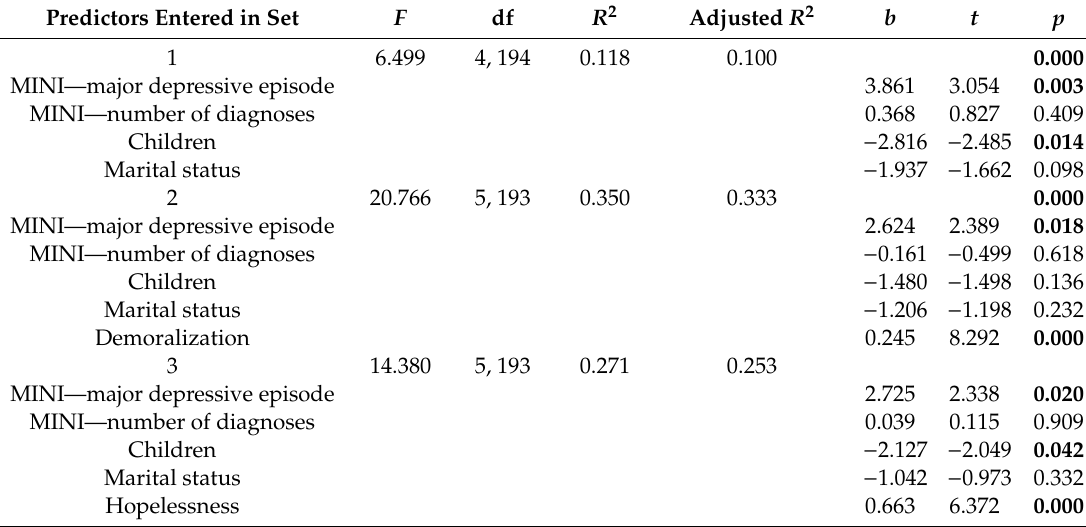
Table 3. Multiple linear regression equation, predicting suicidal ideation as measured by the SSI (n =